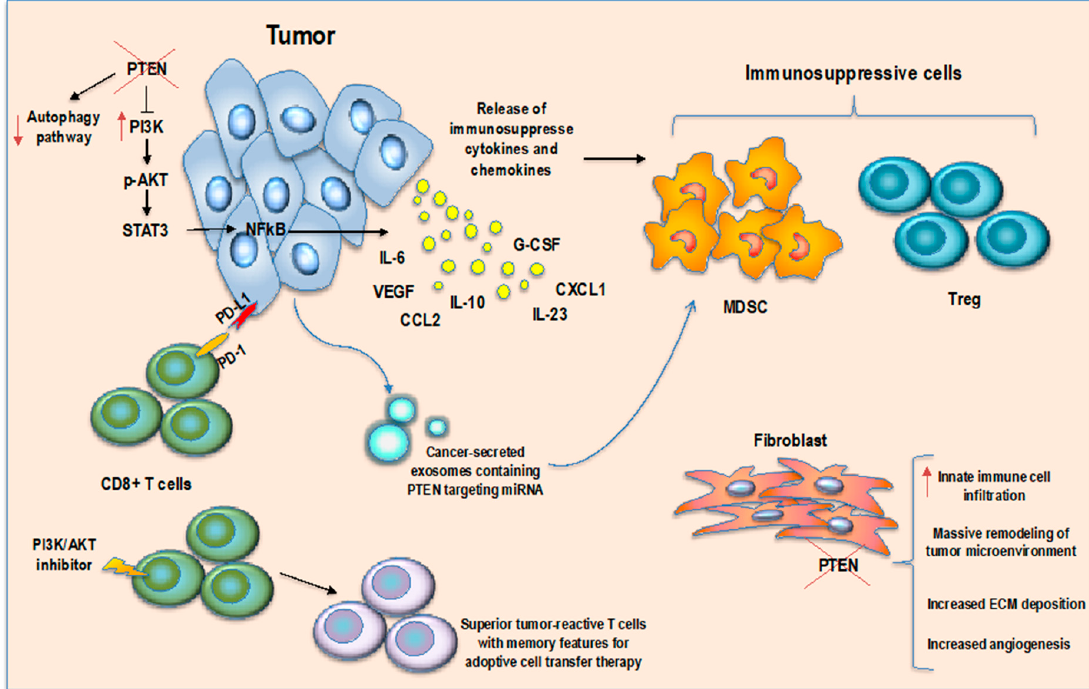
Figure 1. PTEN in cancer immune microenvironment regulation. PTEN loss in tumor cells induces an immunosuppressive microenvironment through secretion of immunosuppressive cytokines and MDSCs/Tregs chemoattractant molecules, inhibition of autophagy pathway and CD8 T cell killing, secretion of miRNA-containing exosomes to target PTEN expression in MDSCs inducing their activation. PTEN loss in fibroblasts surrounding tumor increases immune cell infiltration and induces microenvironment remodeling while inhibition of AKT pathway in T cells enhances memory T cell differentiation.